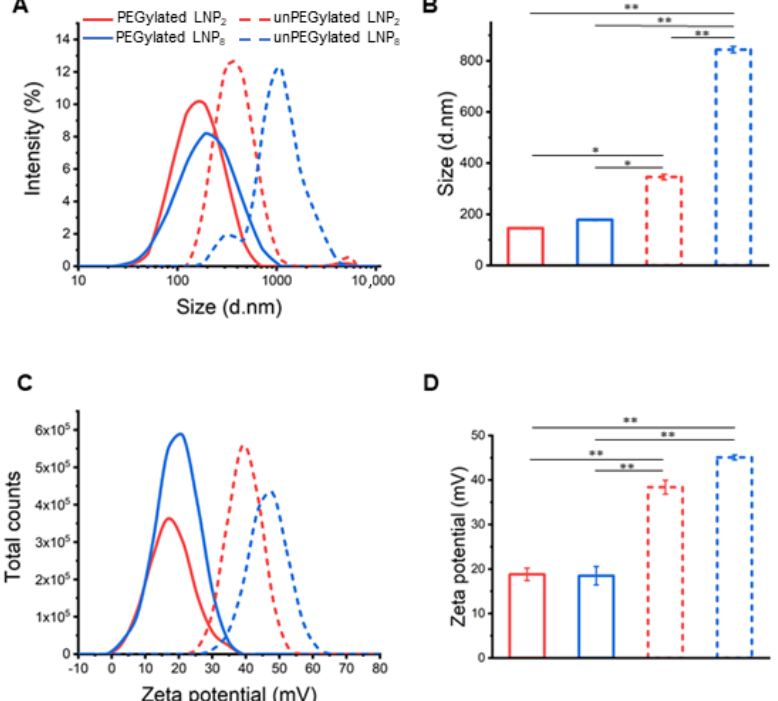
Figure 2. Size ( A ) and zeta potential ( C ) distributions of unPEGylated (dashed lines) and PEGylated (solid lines) LNPs prepared at two different total flow rates (TFR) of 2 mL/min (red lines) and 8 mL/min (blue lines). Average size and zeta potential are displayed in panels ( B ) and ( D ), respectively. PEGylation had a major effect on keeping size of LNPs below the typical threshold size for gene delivery. Moreover, lower TFR produced smaller size and more homogeneous